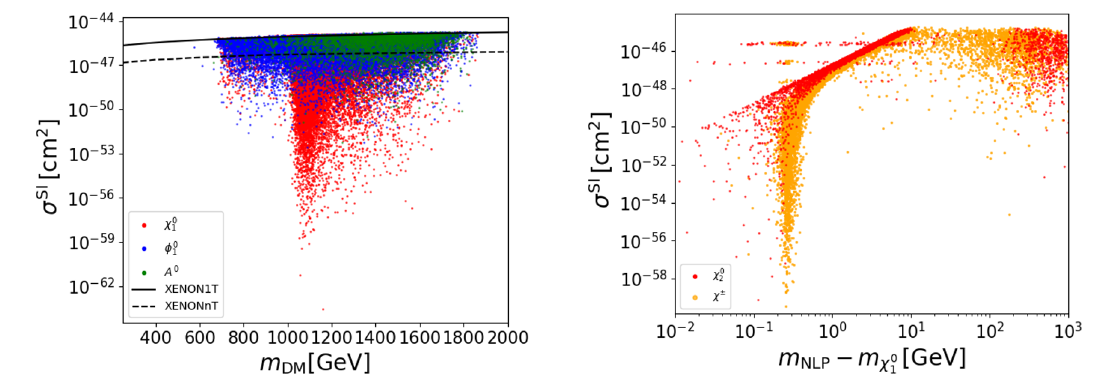
Figure 12 . Left: spin-independent dark matter direct detection cross-section as a function of the dark matter mass. The colours correspond to the different natures of the dark matter. Right: spin-independent dark matter direct detection cross-section versus the mass difference between the dark matter and the next-to-lightest particle (NLP) for the case of fermionic dark matter. The colours correspond to the different natures of the next-to-lightest